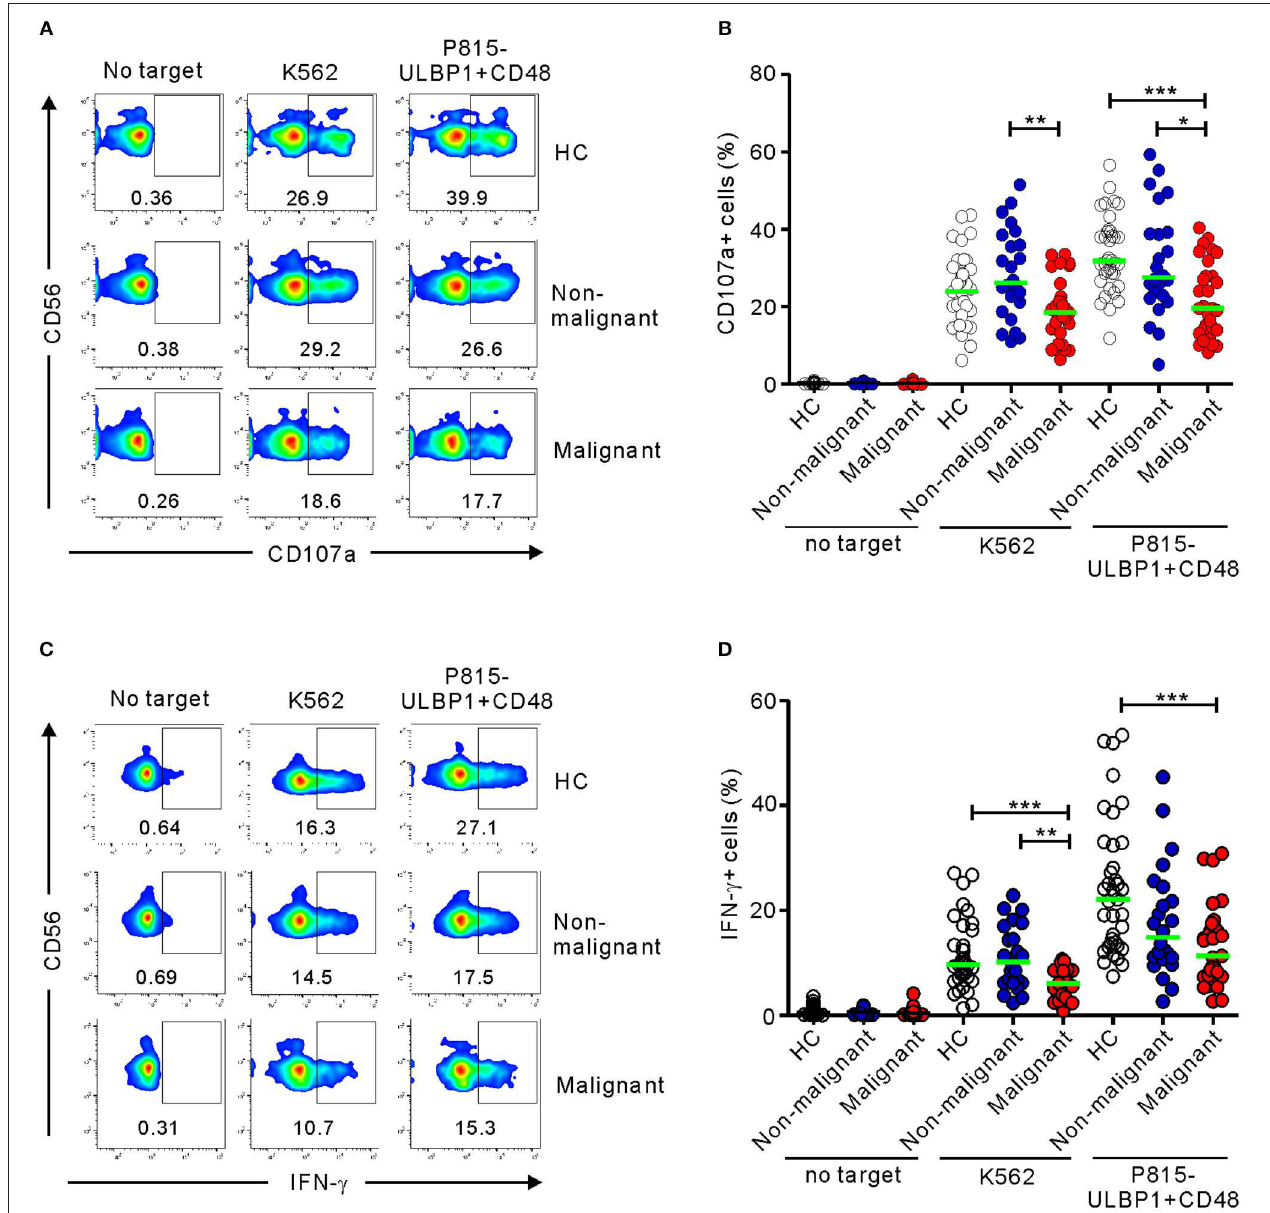
FIGURE 1 | Patients with pancreatic cancer (PC) have impaired NK cell effector functions. PBMCs from the healthy control (HC) group ( n = 37), the non-malignant group ( n = 24), and the malignant group ( n = 31) were incubated with either K562 cells or P815-ULBP1 + CD48 cells, which activate NK cells via NKG2D and 2B4. (A,B) Degranulation of NK cells, as measured by cell surface expression of CD107a. (C,D) Cytokine production by NK cells, as measured by intracellular expression of IFN- γ . (A,C) Representative FACS profiles showing the percentages of CD107a + (A) and IFN- γ + NK cells (C) . (B,D) Summary graphs showing the expression of CD107a (B) and IFN- γ (D) by NK cells. Horizontal bars (green) indicate the medians. Statistical differences between the groups were evaluated with the non-parametric Kruskal-Wallis test. * P < 0.05, ** P < 0.01, and *** P <